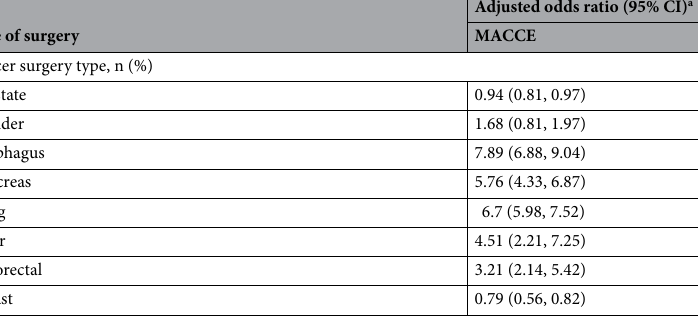
Table 3. Association of cancer surgeries and perioperative major adverse cardiovascular and cerebrovascular events. MACCE major adverse cardiovascular and cerebrovascular events. a Multivariable models include age, race, obesity, tobacco use, hypertension, hyperlipidemia, diabetes mellitus, chronic kidney disease, end-stage renal disease, coronary artery disease, prior revascularization with either percutaneous coronary intervention or coronary artery bypass surgery, peripheral arterial disease, valvular heart disease, congestive heart failure, prior venous thromboembolism, chronic lung disease, alcohol abuse, anemia, and year of hospitalization as